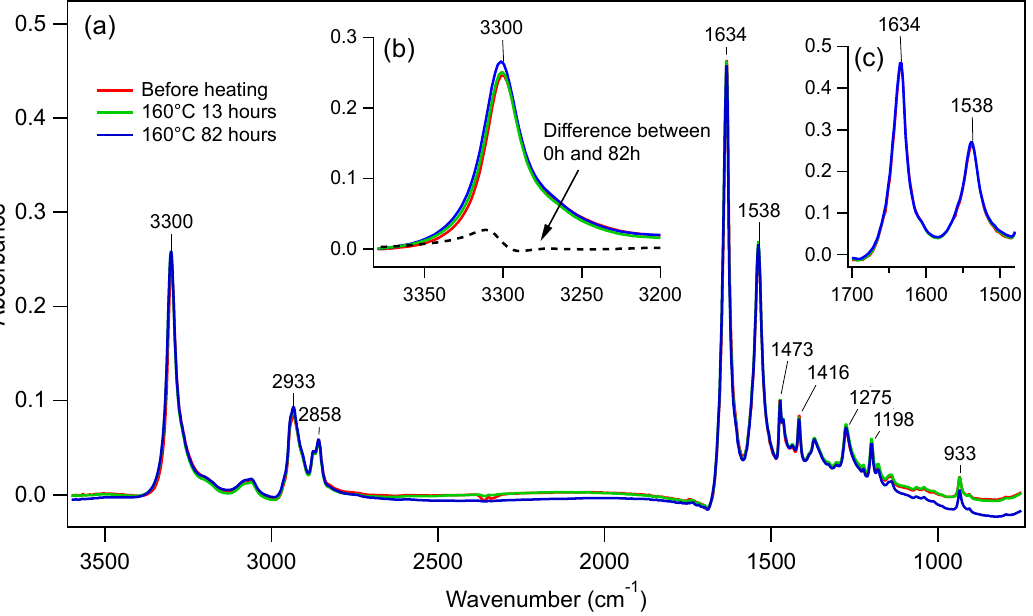
Figure 3. ( a ) FTIR spectra of PA66 before and after heating at 160 ◦ C for 13 h and 82 h, and enlarged spectra; ( b ) amine group region around 3200 − 3600 cm − 1 with difference spectrum; and ( c ) carbonyl group region around 1450 − 1700 cm − 1